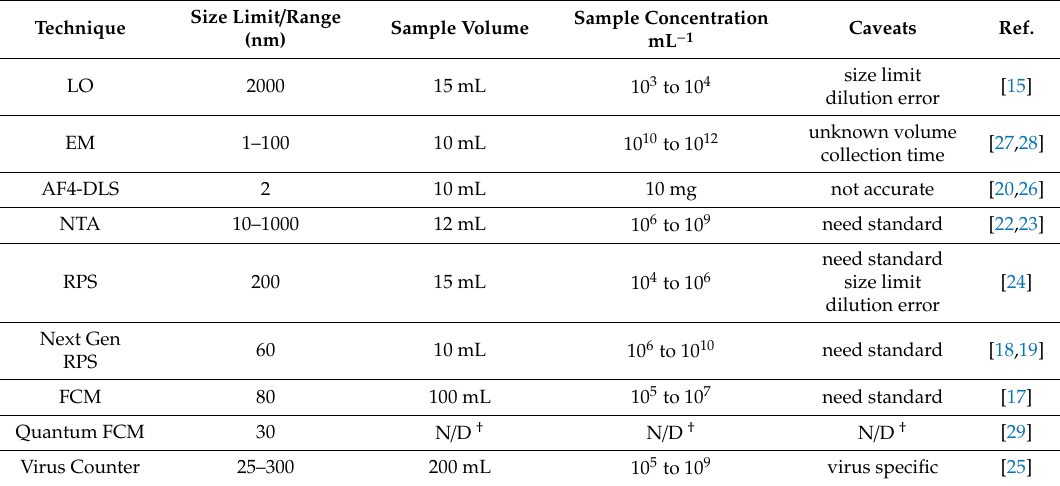
Table 3. Particle Counting Techniques for Beads include light obscuration (LO), electron microscopy (EM), asymmetrical flow field-flow fractionation with dynamic light scattering (AF4-DLS),